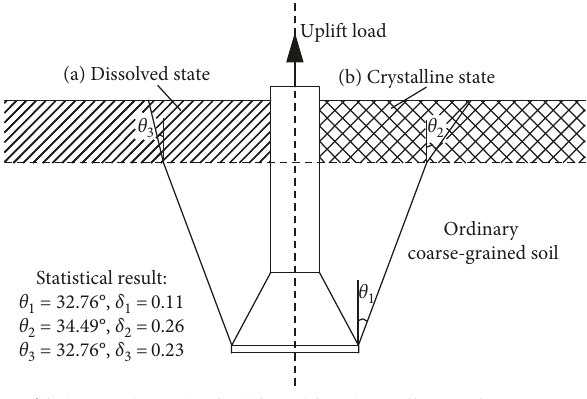
Figure 14: Failure modes for belled pier foundation in coarse-grained saline